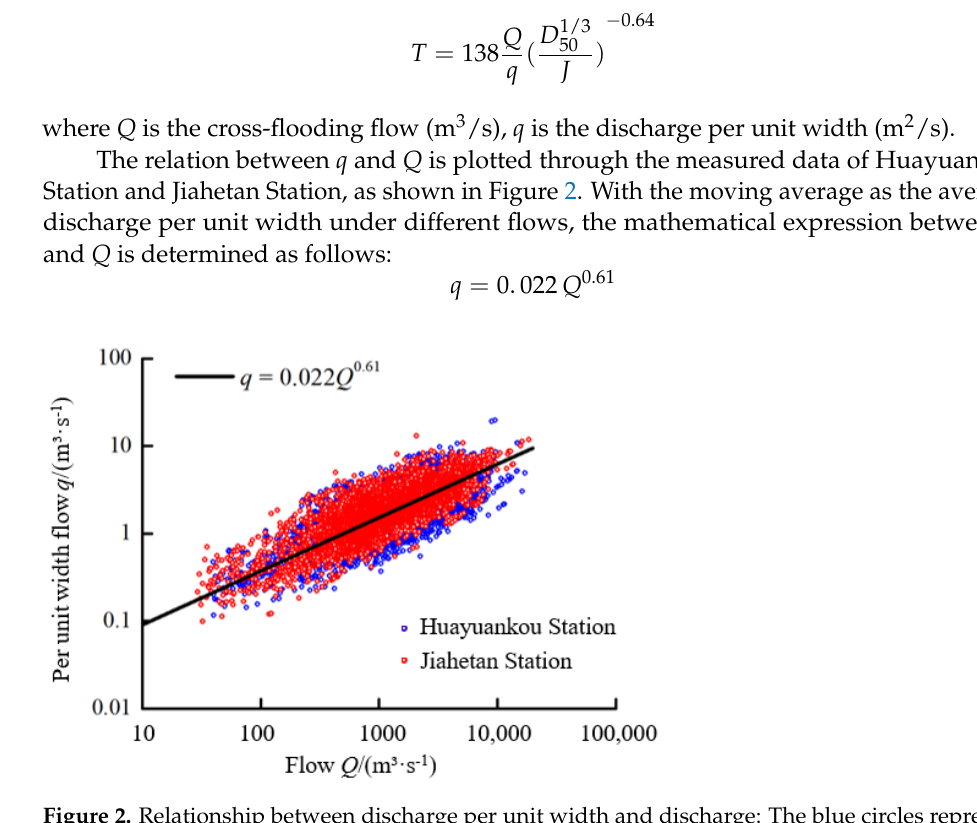
Figure 2. Relationship between discharge per unit width and discharge: The blue circles represent Jiahetan station and the red circles represent Huayuankou Station.